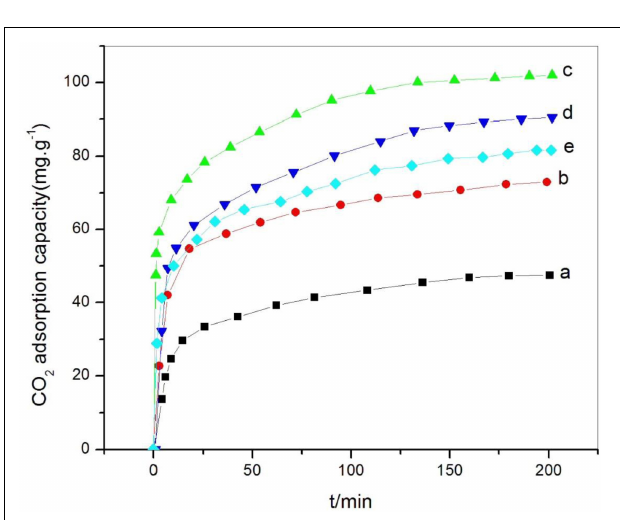
FIGURE 10 | CO 2 adsorption capacity of MMO-PEI-60 at (a) 20; (b) 40; (c) 70; (d) 85 and 100 ◦